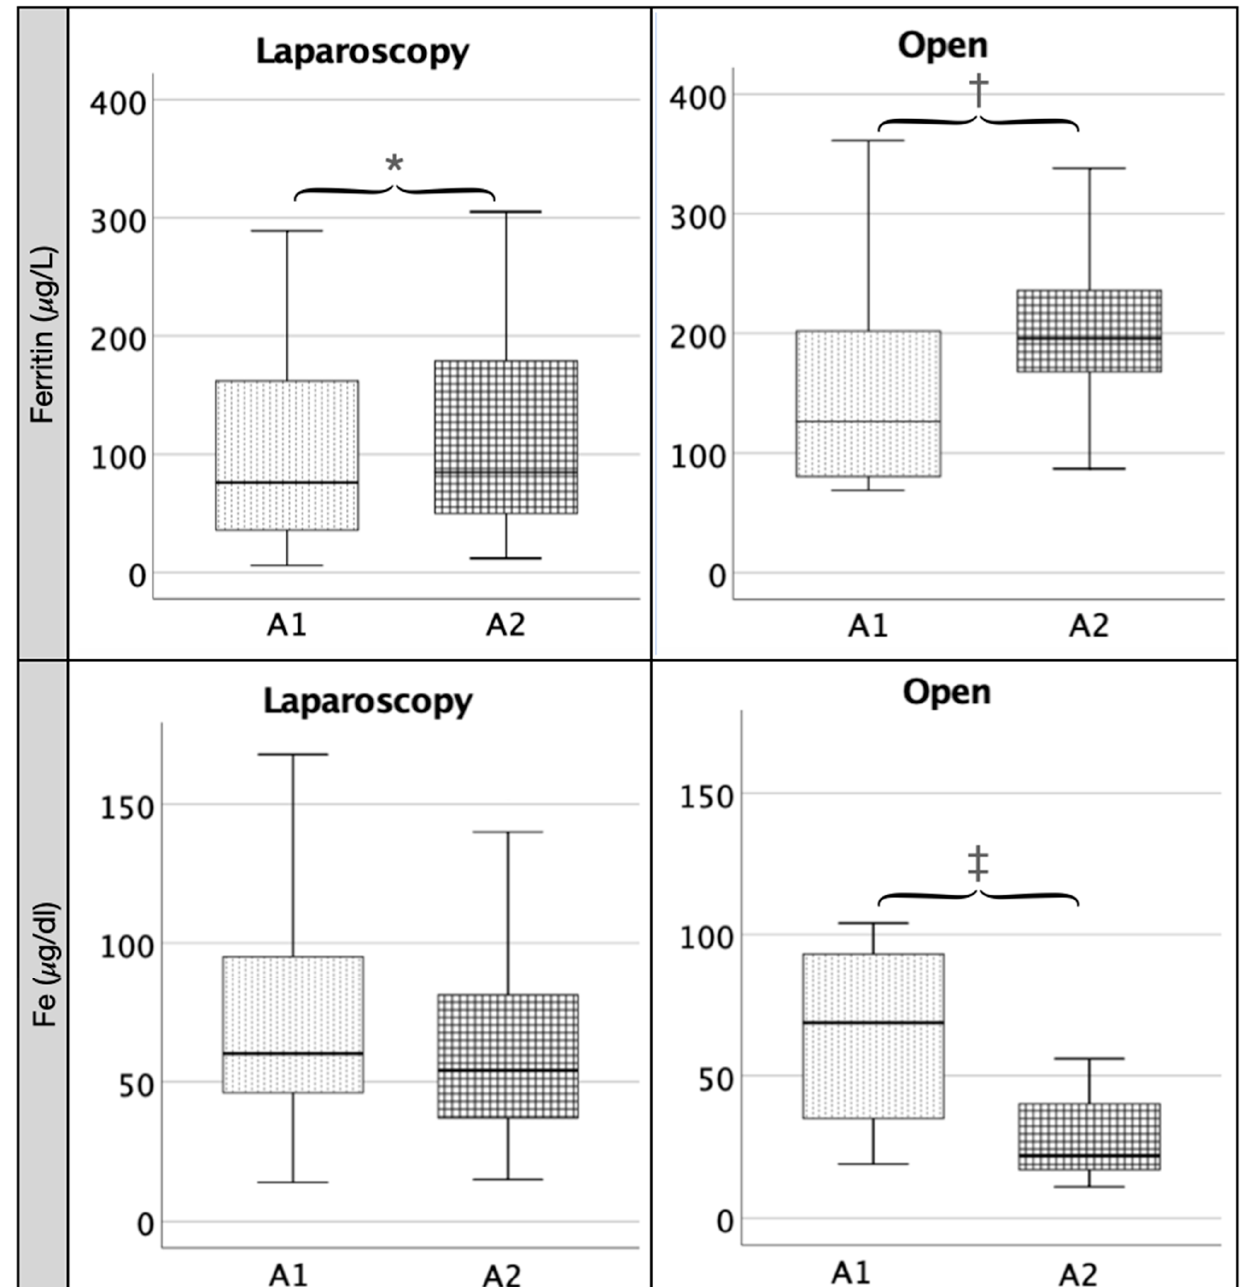
Figure 1. Comparison between A1 and A2 in laparoscopic (LC) and open cholecystectomy (LC): ferritin and Fe. Legend: Both in the laparoscopy and the open group, there is a significant increase in ferritin between baseline (A1) and 24 h (A2) values ( ∗ = 0.00; † = 0.03). In the open group, there is a signi fi cant decrease in Fe between A1 and A2 values (‡ = 0.01).